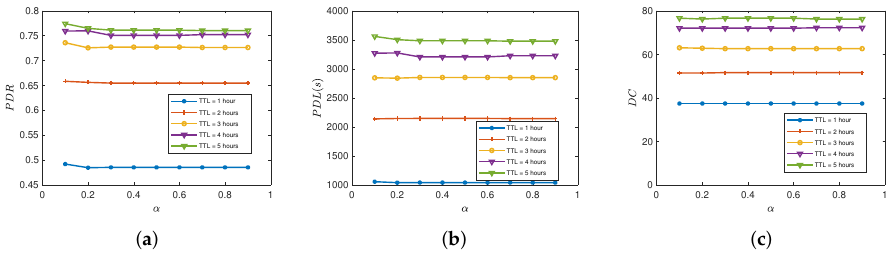
Figure 3. The network performance for various values of α . ( a ) PDR . ( b ) PDL . ( c ) DC